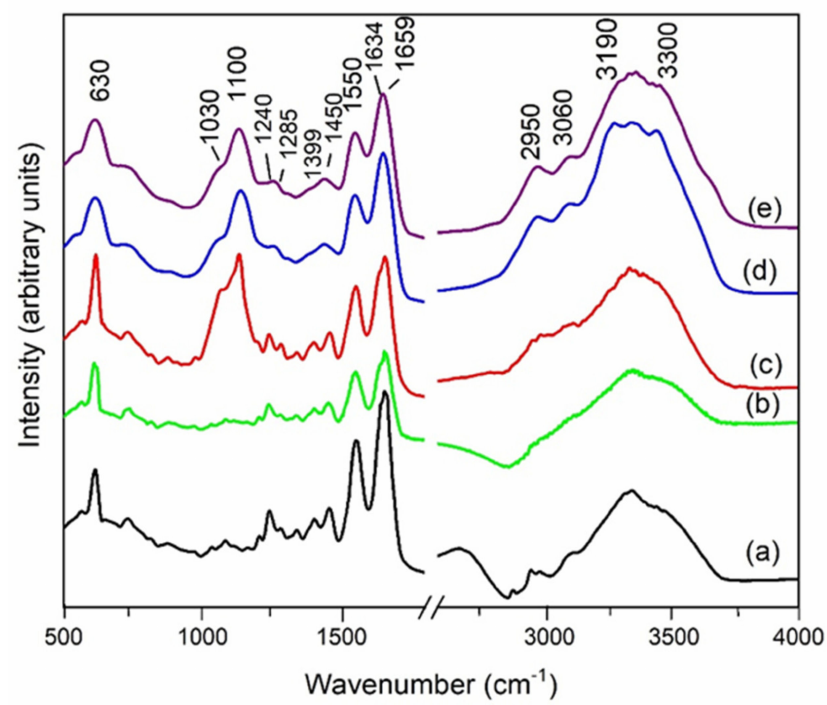
Figure 3. FTIR spectra of AM specimens after treatment with antibiotic and/or UV: ( a ) natural AM without any treatment (AMN); ( b ) AM exposed to UV for 1 h (AUV); ( c ) AM treated with gentamicin (40 mg/mL) and exposed to UV for 1 h (AGUV); ( d ) AM treated with gentamicin 40 mg/mL (AG40); ( e ) AM treated with gentamicin 80 mg/mL (AG80).